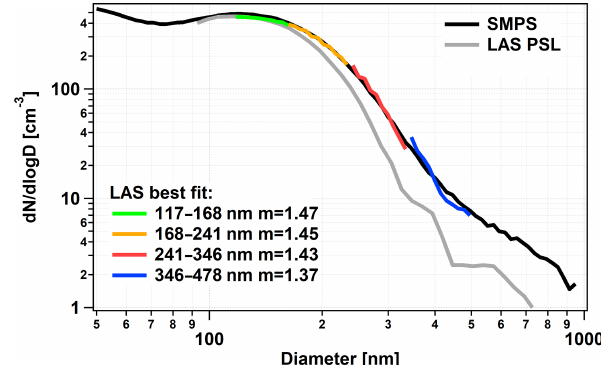
Figure 9. The average dry scattering coefficient size distribution (black line) at the 633nm wavelength and the corresponding parti- cle number size distribution (blue line, right axis) as a function of the particle diameter. The gray lines show the 10th, 25th, 50th, 75th, and 90th percentiles of the scattering coefficient distribution.